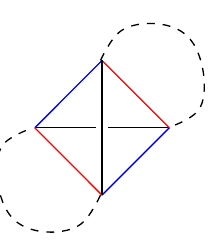
Figure 9 . The NLO core graph for the CTKT model in the tetrahedron